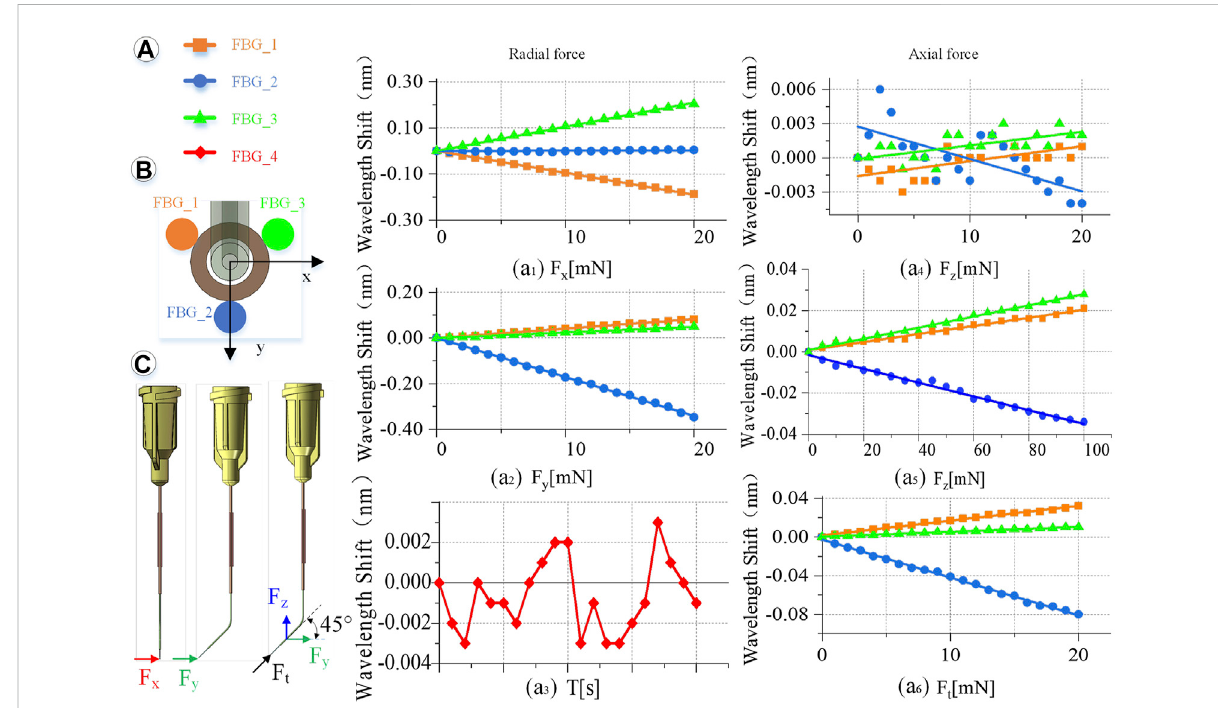
FIGURE 5 Calibration experiment results. (A) Wavelength change of the re fl ected light of the four FBG sensors. (a 1 ) When F x is 0 – 20 mN. (a 2 ) When F y is 0 – 20 mN. (a 3 ) In fl uence of temperature on the feedback wavelength change of FBG sensor during the experiment. (a 4 ) When F z is 0 – 20 mN. (a 5 ) When F z is 0 – 100 mN. (a 6 ) When F t is 0 – 20 mN. (B) FBG sensor number and layout. (C) Direction of the force on the end of the injection